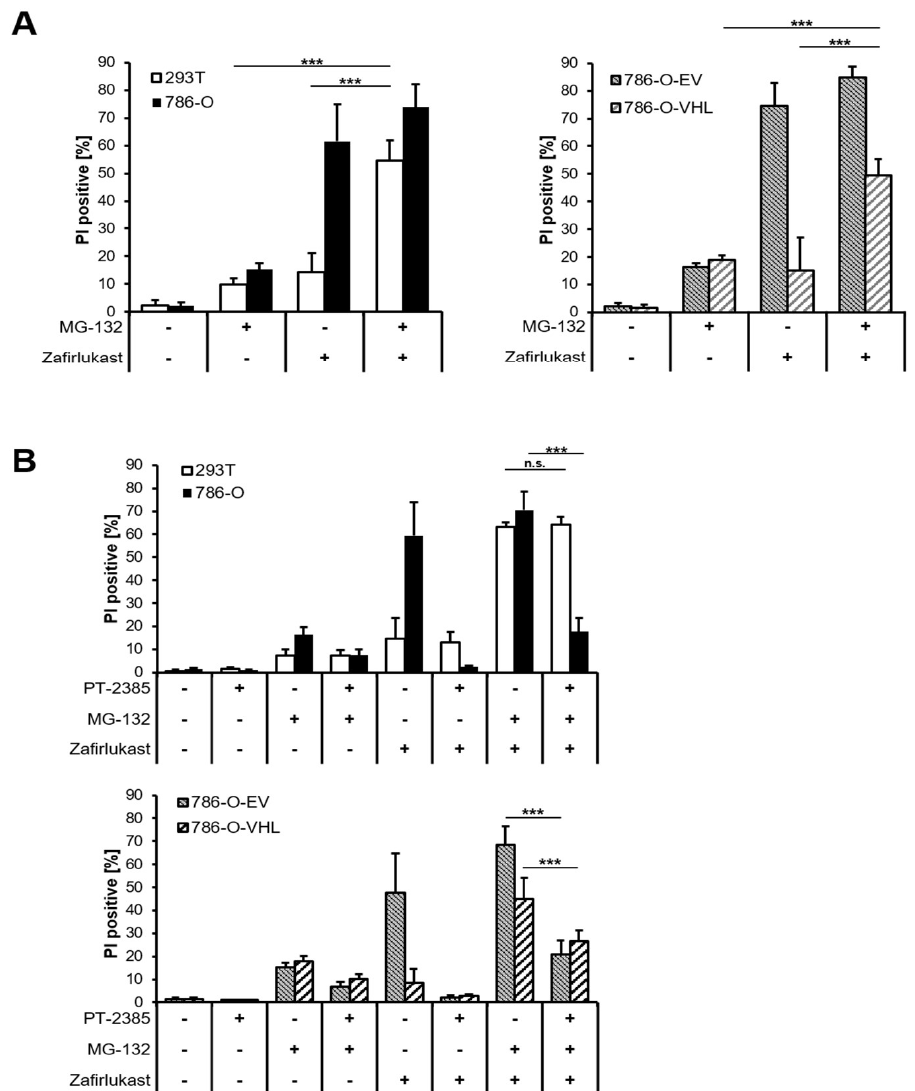
Figure 6. Proteasome inhibition regulates pVHL- and HIF-2α-dependent cell death triggered by zafirlukast. ( A ) 786-O and 293T ( left ) and 786-O-EV and 786-O-VHL ( right ) cells were pre-treated with the proteasome inhibitor MG-132 (10 µM) for 1 h, followed by treatment with DMSO or 100 µM zafirlukast for 24 h, after which cell death was determined by quantifying PI uptake. Data are presented as percentage of PI-positive cells and mean and SD of three independent experiments performed in triplicate are shown. *** p < 0.001, n.s.: non-significant; ( B ) 786-O and 293T (upper) and 786-O-EV and 786-O-VHL (lower) cells were pre-treated with the HIF-2α inhibitor PT-2385 (20 µM) for 24 h, followed by incubation with the proteasome inhibitor MG-132 (10 µM) for 1 h and treatment with DMSO or 100 µM zafirlukast for 24 h, after which cell death was determined by quantifying PI uptake. Data are presented as percentage of PI-positive cells and mean and SD of three independent experiments performed in triplicate are shown. *** p < 0.001, n.s.: non-significant.